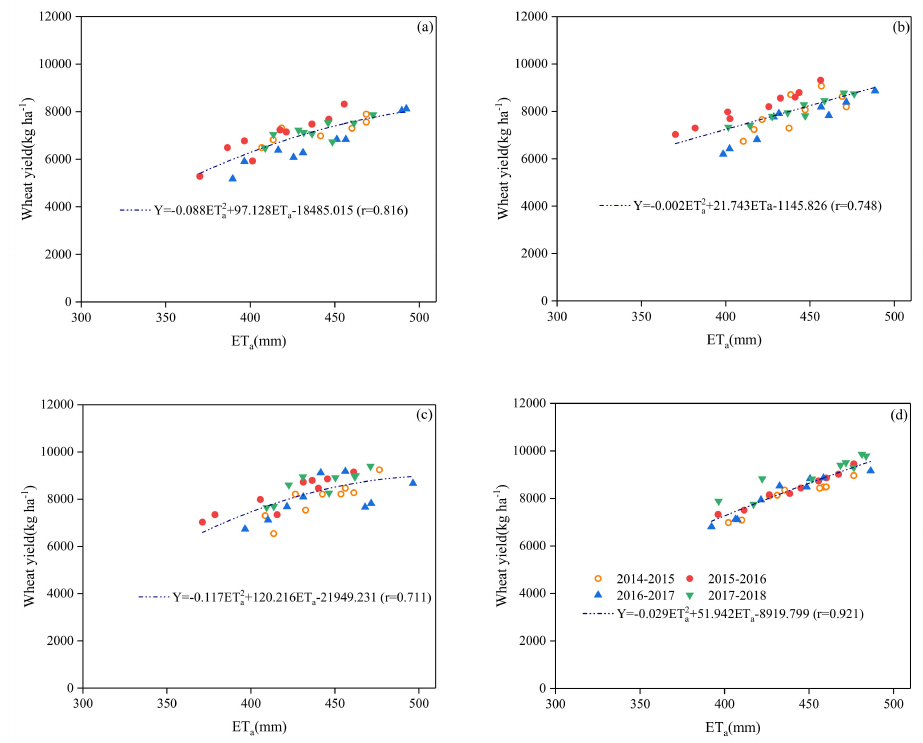
Figure 3. Relationships between ET a and wheat yield in the treatment of N 120 ( a ), N 180 ( b ), N 240 ( c ), and N 300 ( d ) in the four consecutive seasons from 2014 to 2018.